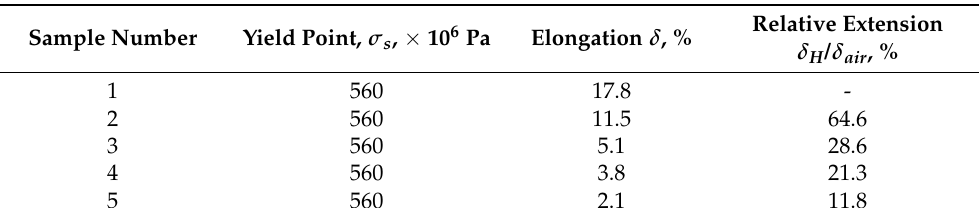
Table 10. Mechanical parameters of pipeline steel of strength class X80 when testing samples of initial (1, 3, 4) and hydro- genated (2, 5) in air (1, 2) and in the presence of external hydrogen (3, 4, 5) [61]. Sample Number